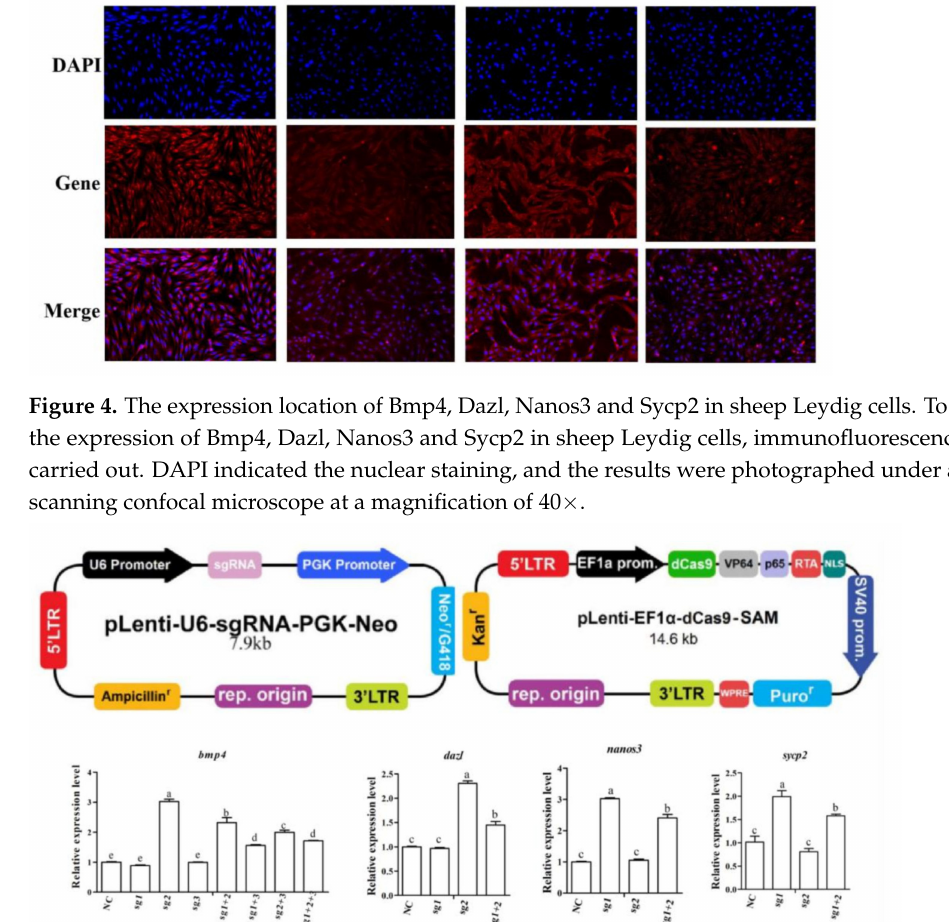
Figure 5. Overexpression of bmp4 , dazl , nanos3 and sycp2 in sheep fibroblasts. To overexpress the candidate genes bmp4 , dazl , nanos3 and sycp2 , sgRNAs were designed and transfected in sheep ear fibroblasts. The transfection efficiency was proven by the qPCR experiment, and the results were expressed relative to the control group (NC) as mean values ± the SEM. Different letters mean significant differences between groups ( p <